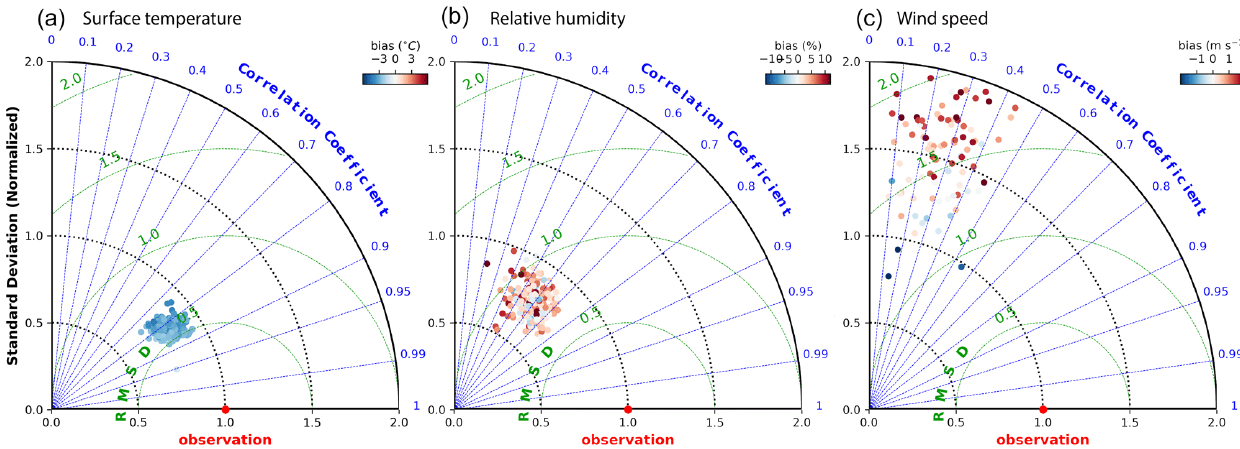
Figure 3. Taylor diagrams showing the agreement between measured and model-calculated surface temperatures (a) and relative humidity (b) and wind speed (c) . Each data point corresponds to an individual measurement station, with a total of 178, 197 and 95 stations for surface temperature, relative humidity, and wind speed, respectively.